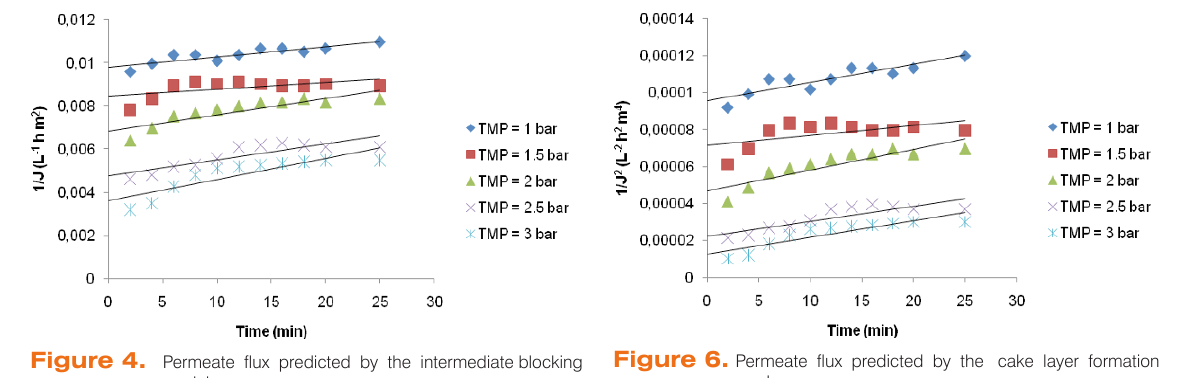
Figure 3. Permeate flux predicted by the complete blocking model.